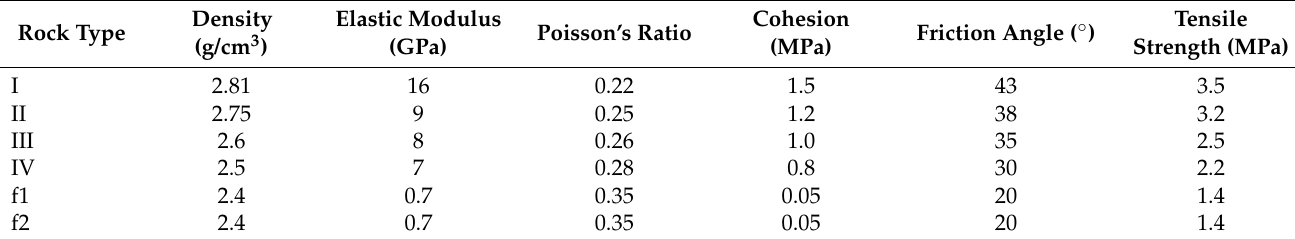
Figure 4. Excavation sequence of the three caverns.